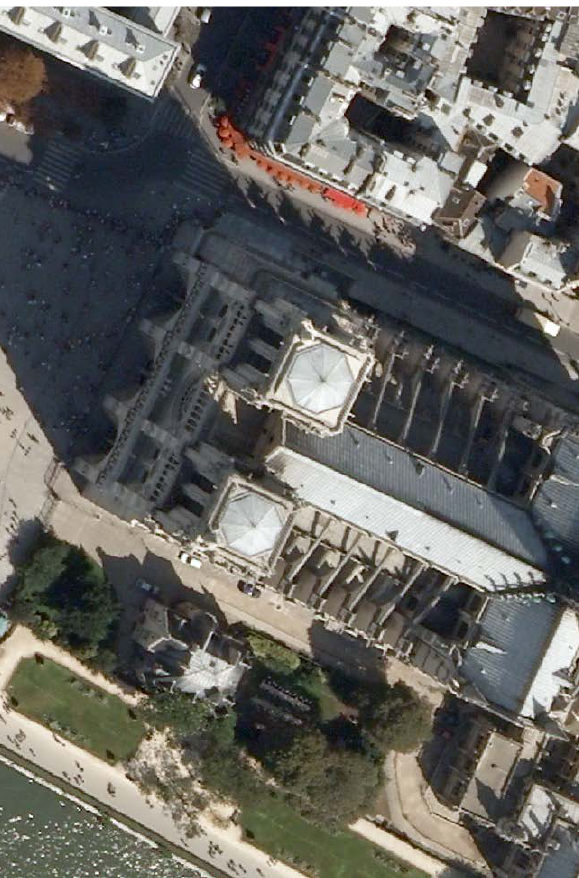
Fig. 13: Corresponding regular